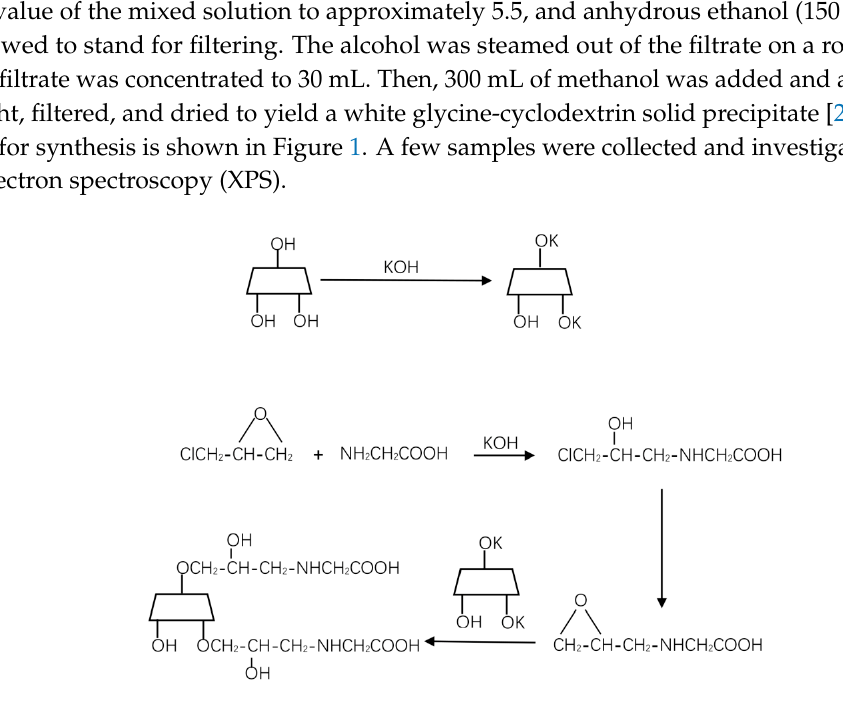
Figure 1. Reaction scheme for synthesis of G- β -CD.